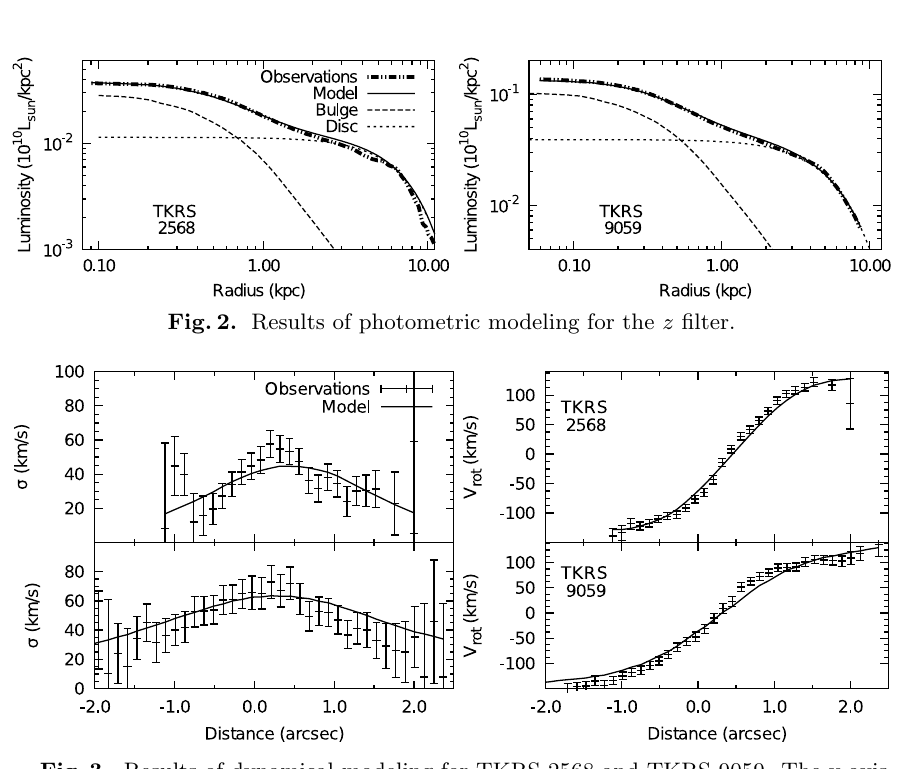
Fig. 3. Results of dynamical modeling for TKRS 2568 and TKRS 9059. The x axis is from the slit